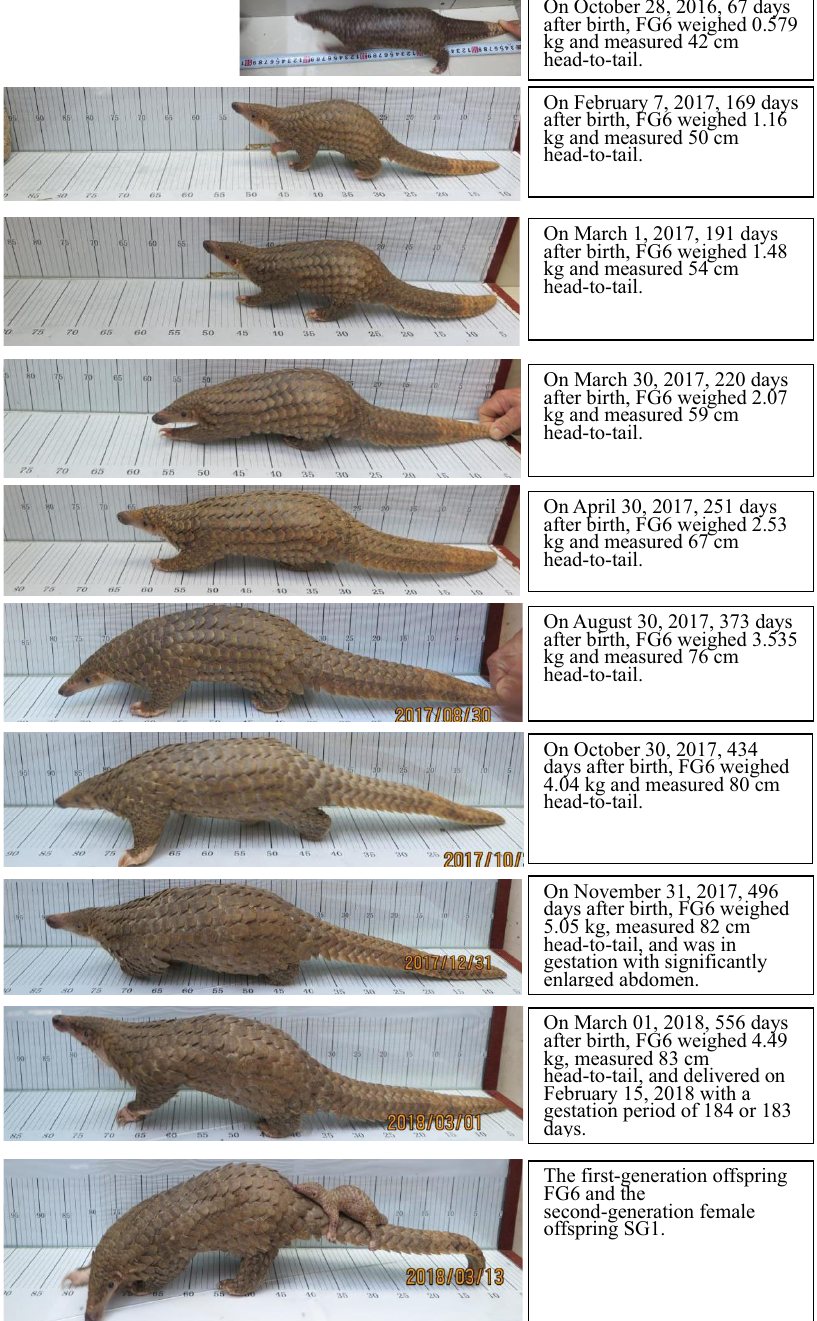
Fig. 5 Growth rate in pangolin. Growth process of the fi rst-generation Malayan pangolin ( M. javanica ) offspring FG6. (Photos: Dingyu